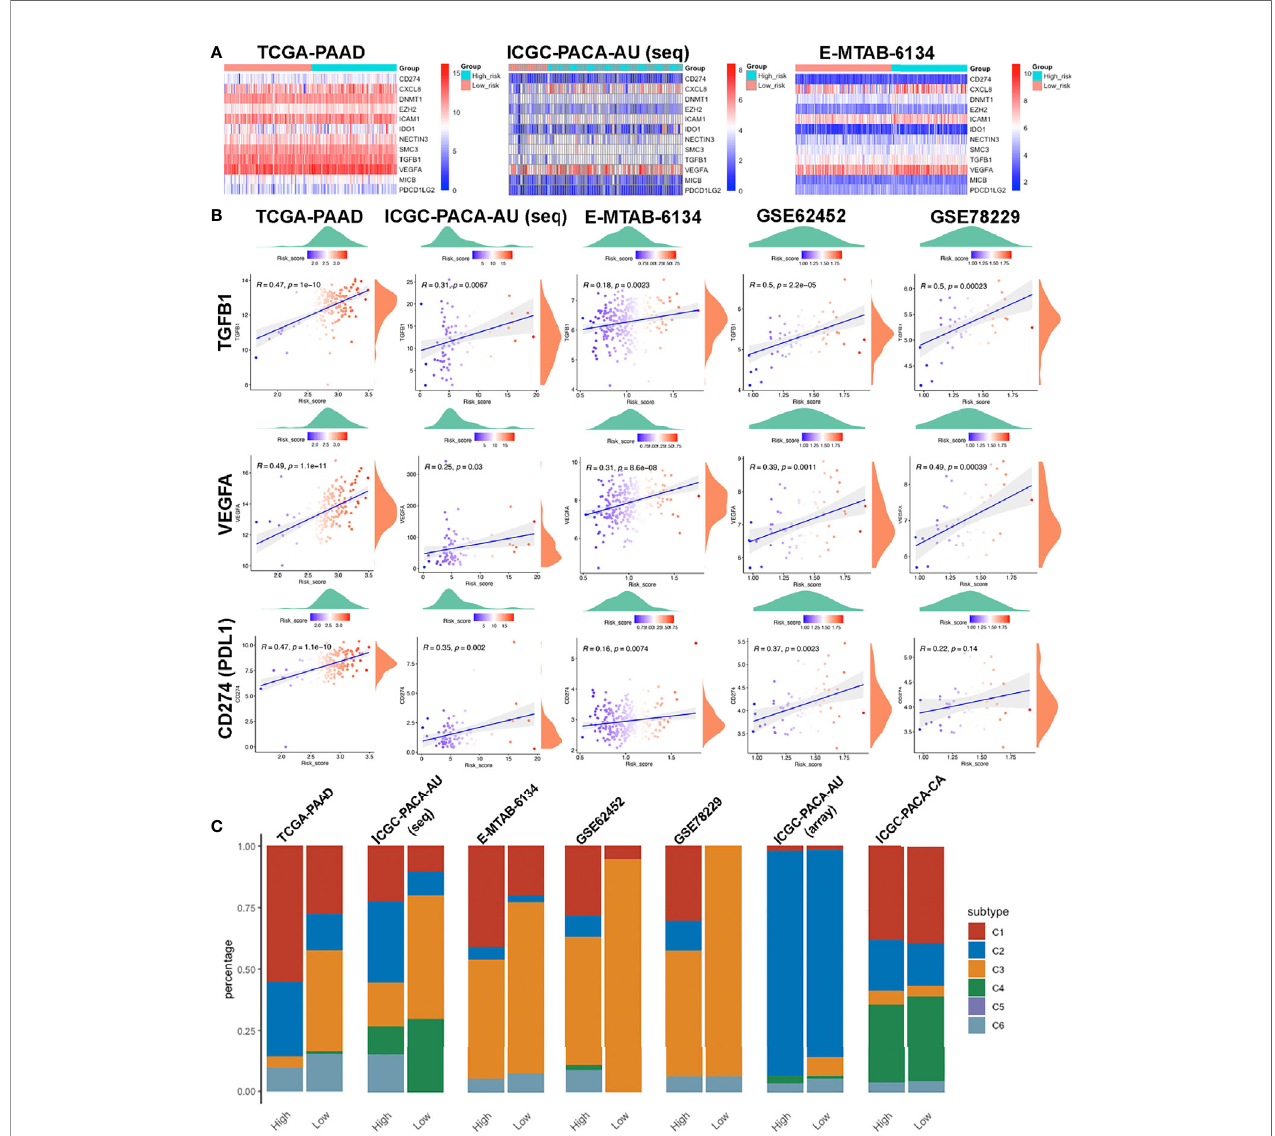
FIGURE 8 | Features of the immune-related biomarkers between patients in high and low risk-score subgroups. (A) Heatmaps of 12 CIC negative regulatory genes in TCGA-PAAD, ICGC-PACA-AU and E-MTAB-6134 datasets. (B) Correlations between CTLA4, PDCD1, CD274 (PDL1) and risk-scores in TCGA-PAAD, ICGC- PACA-AU (seq), E-MTAB-6134, GSE62452 and GSE78229 datasets. (C) Distribution of immune subtypes across all included